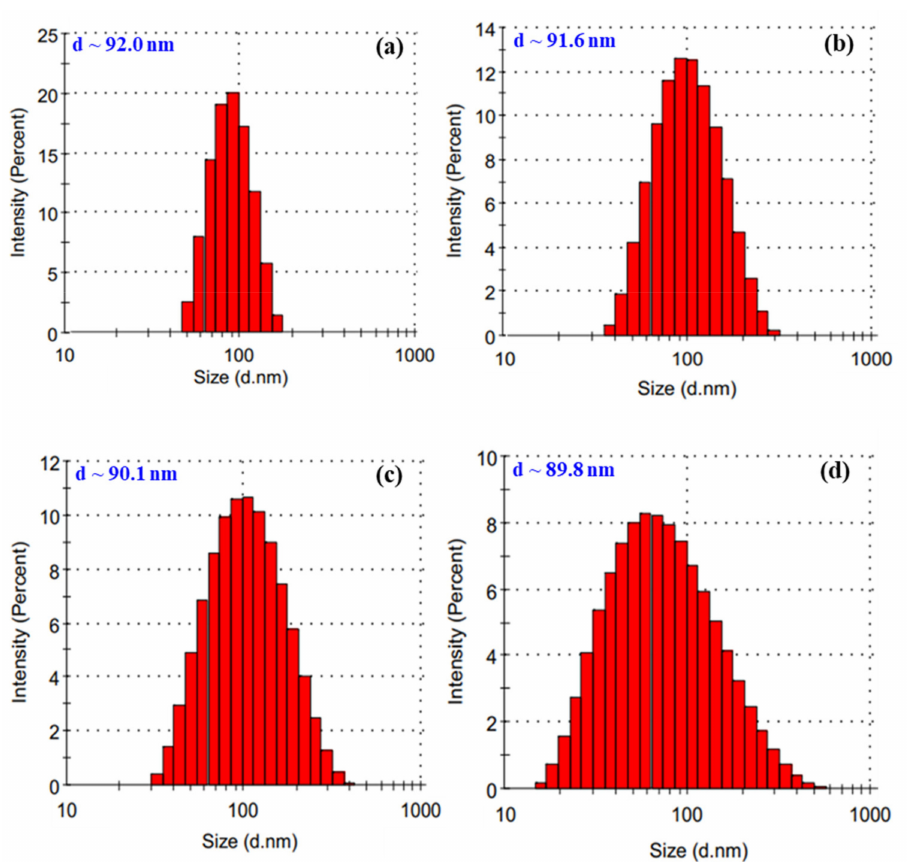
Figure 3. Particle size and size distribution of SeNPs/ β -glucan samples of 80 ppm SeNPs synthesized in various pH conditions. ( a ) pH~5; ( b ) pH~6; ( c ) pH~7 and ( d )